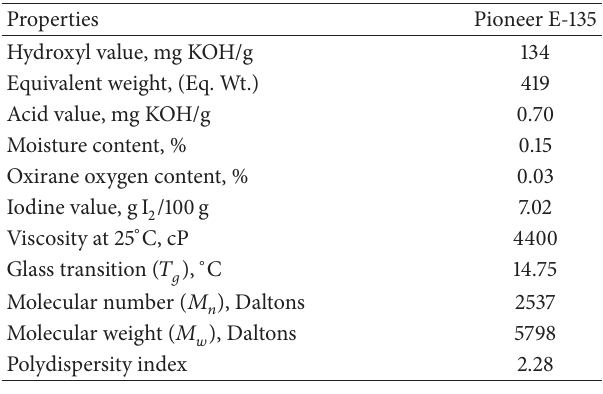
Table 1: Properties of Pioneer E-135.